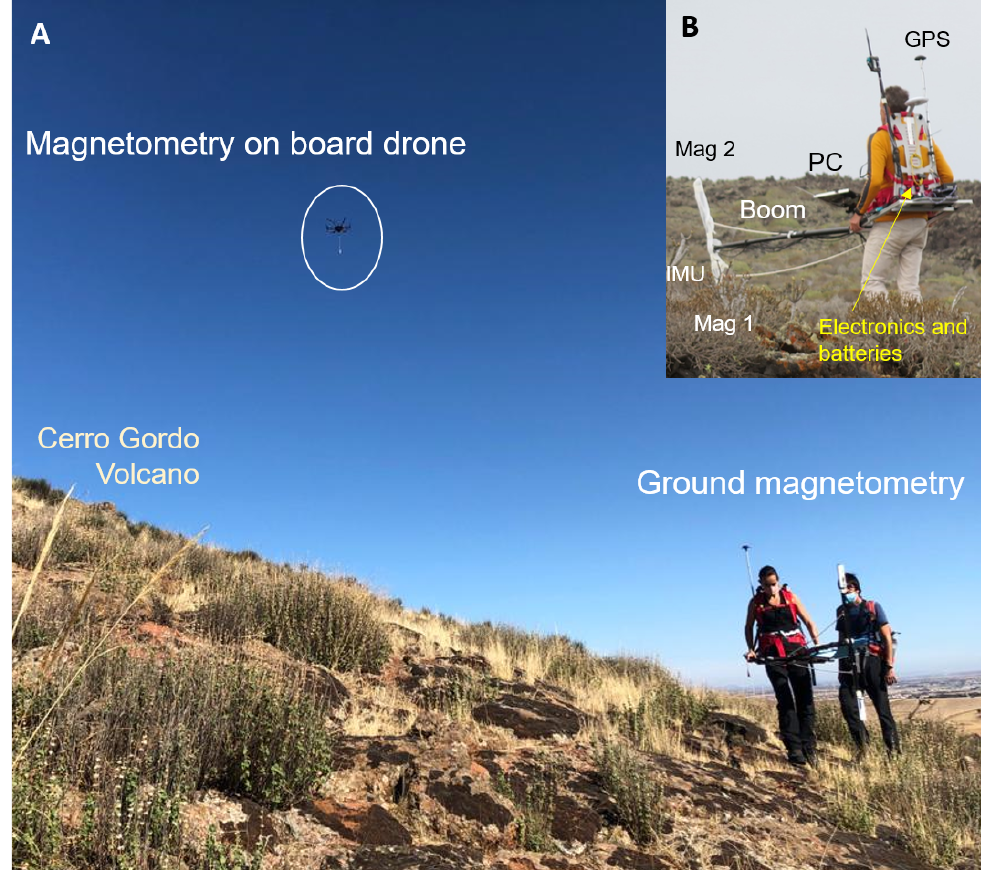
Figure 2. ( A ) Onboard drone and on-ground magnetometry. ( B ) Details of the ground magnetome- try equipment. equipment.